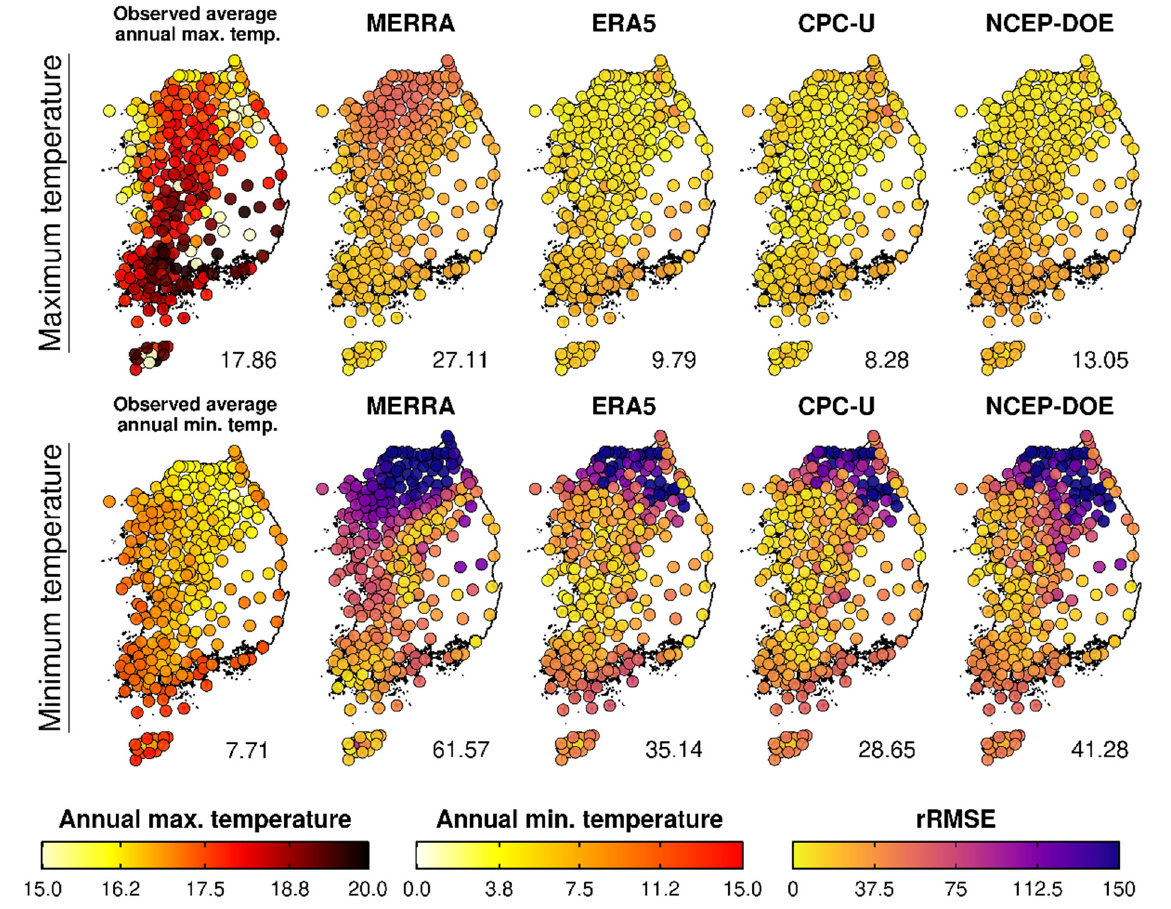
Figure 3. Spatial patterns of rRMSE for annual maximum ( top ) and minimum ( bottom ) temperatures of four grid datasets (each column) from observations. The median value of rRMSE metric at 356 stations is also presented for each sub-figure.